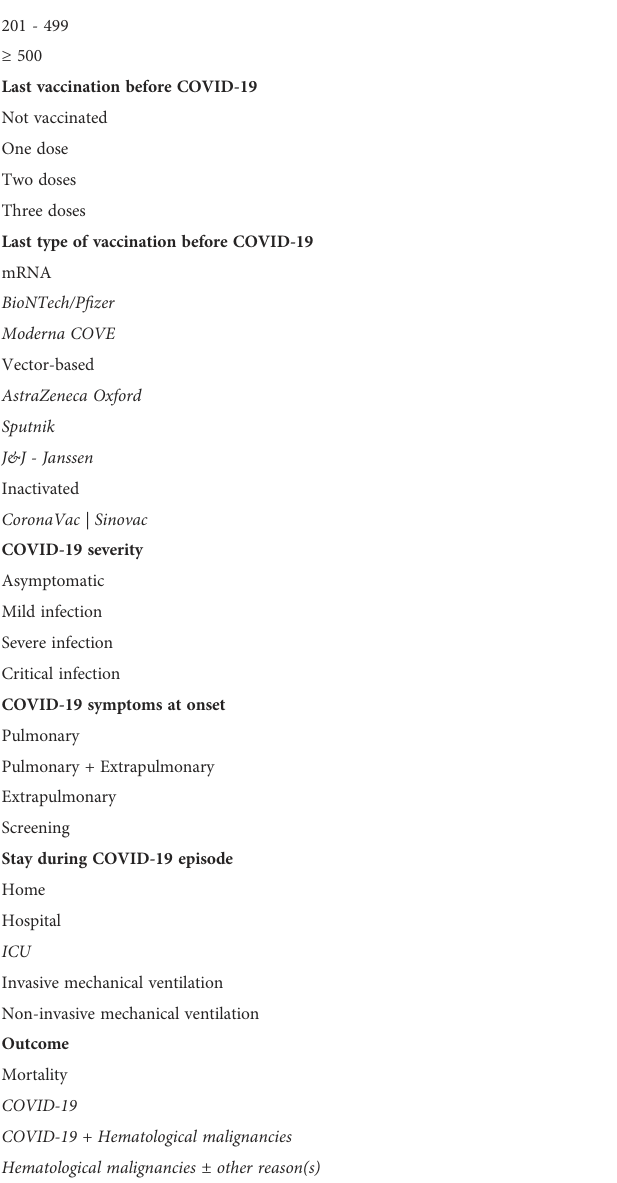
(Table 2). Of note, only 21.0% of the patients had received two or more doses of SARS-CoV-2 vaccine at the onset of COVID-19: mRNA vaccines were administered in 83% patients. Respiratory symptoms were present in 66.1% of patients (n= 242) while 16.9% (n= 62) presented with extrapulmonary symptoms. Of note, our series includes 16.9% (n=62) asymptomatic COVID-19 patients detected upon screening. The majority of patients (n=277, 75.7%) were hospitalized, with a median stay of 16 days (IQR 8-26, range, 1-137).